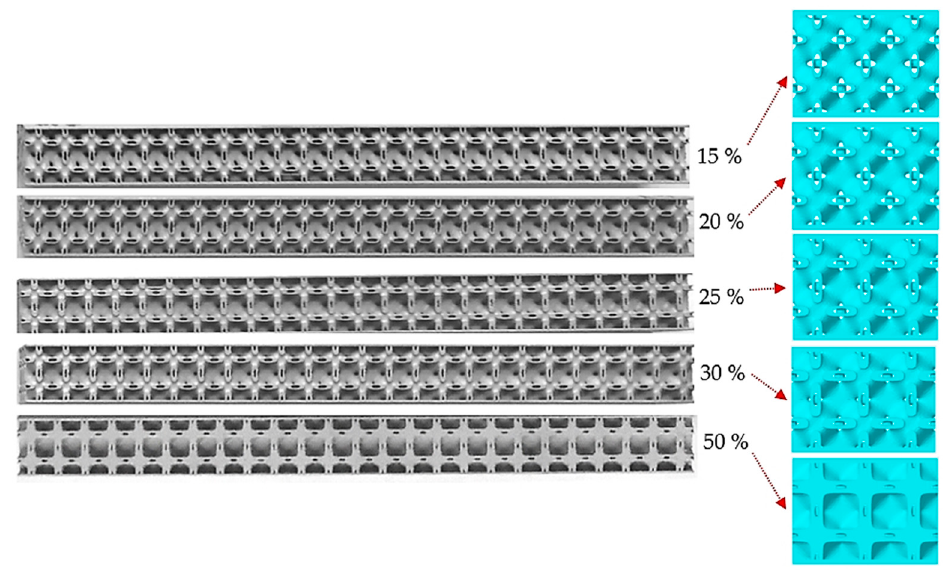
Figure 4. The cross-sectional layout of the sample design.